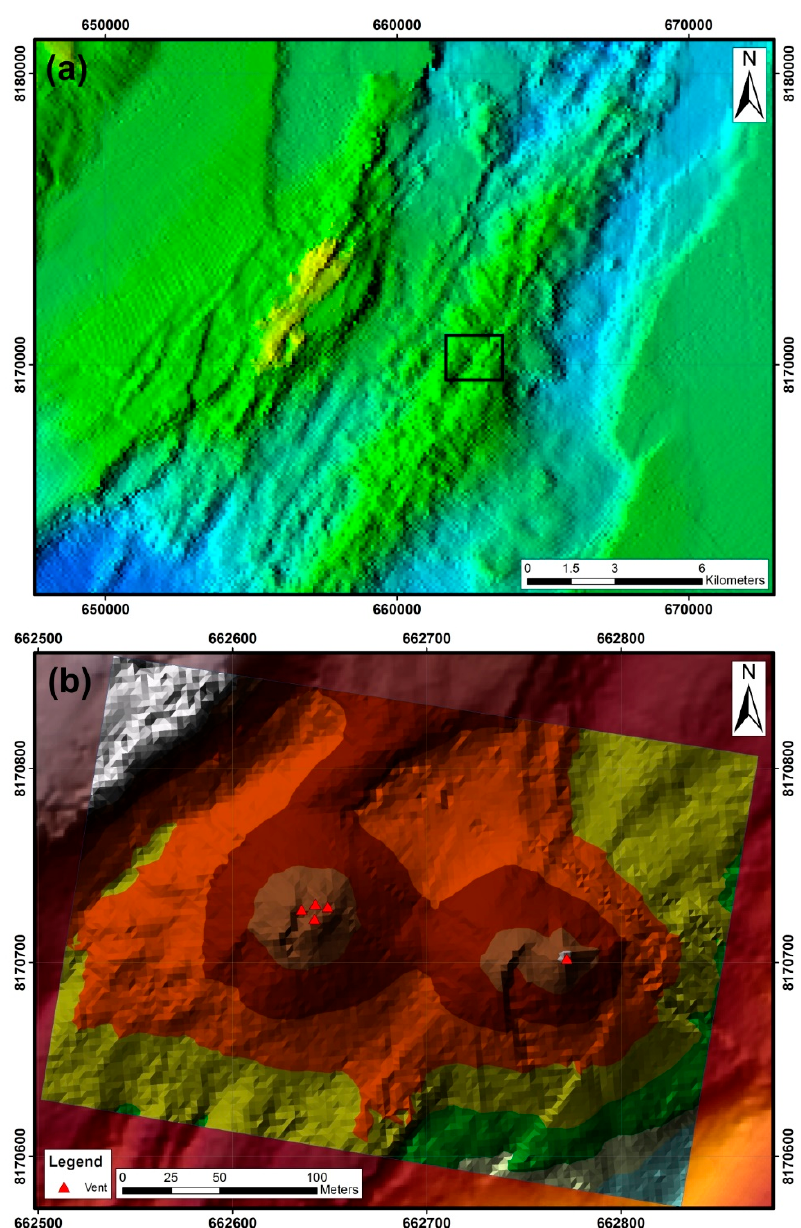
Figure 2. Bathymetry of the Loki’s Castle vent system indicating ( a ) the axial volcanic ridge (AVR) and ridge rift, adjacent dome structure, and inset of ( b ) mound topography. Bathymetric after data from [29].